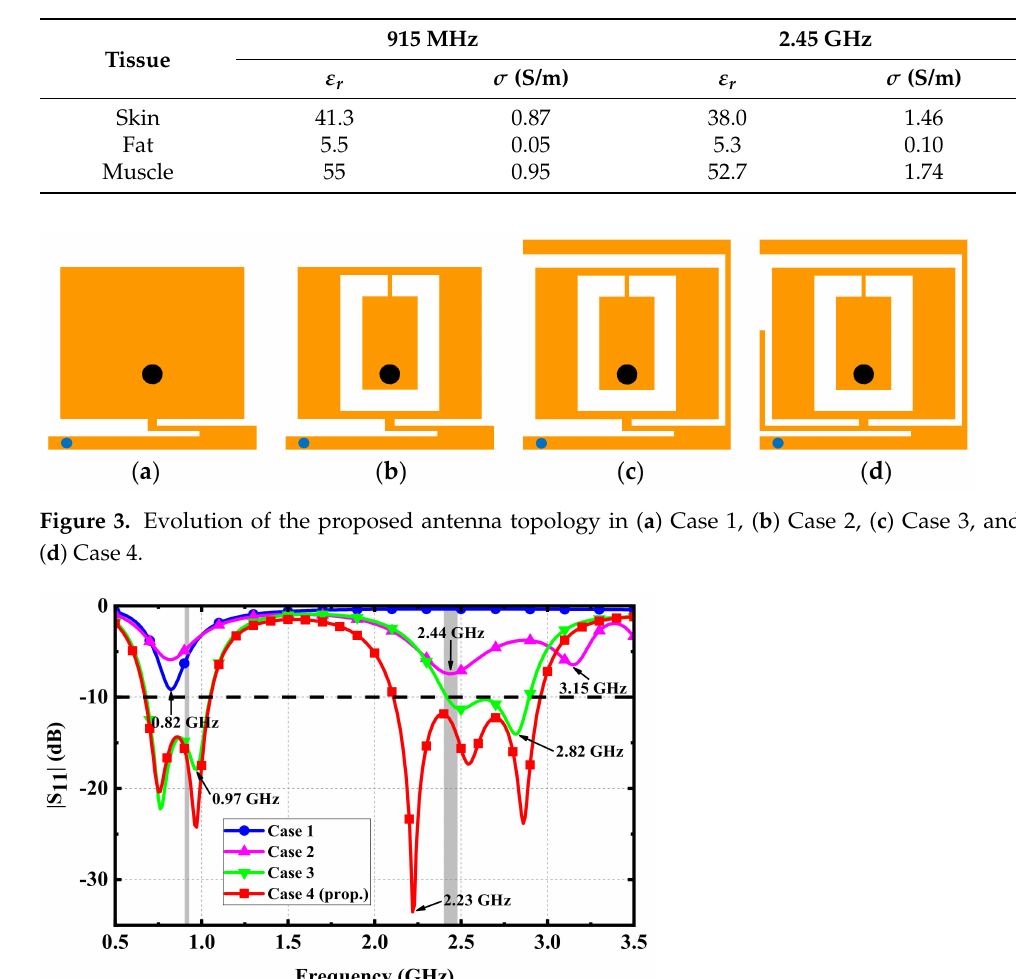
Table 2. Dielectric Properties of Three-Layer Human-Tissue Model.